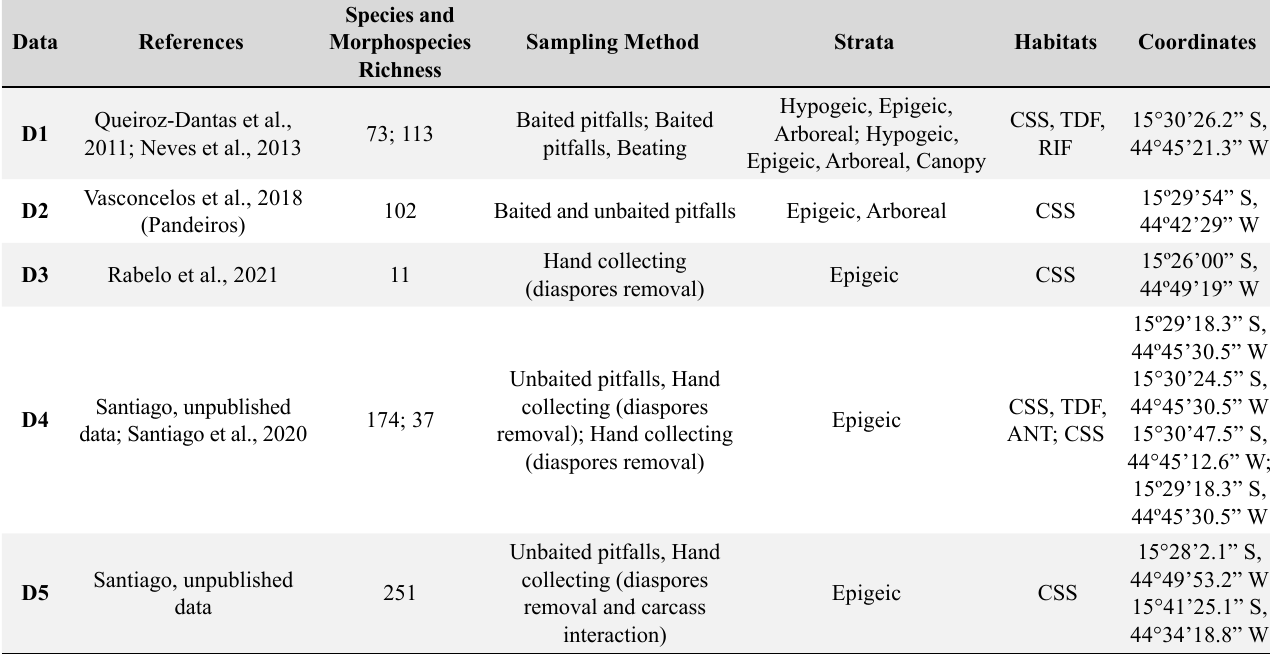
Table 1. References, species and morphospecies richness, sampling methods, strata, habitats and geographic coordinates related to datasets (Ds). A and B are parts of the same datasets published or considered separately: (D1) PCT-Hidro “Dinâmicas de organismos associados aos ambientes de matas ciliares, cerrado e floresta estacional decidual, no médio São Francisco, Norte de Minas Gerais”. (CNPq grant ED. 35/2006, no. 555978/2006-0); (D2) “Rede de Pesquisa Biota do Cerrado – Isoptera e Hymenoptera” (CNPq grant 457407/2012-3) and (FAPDF, Projeto PRONEX 563/2009); (D3, D4, D5) “Desenvolvimento de ferramenta para priorização de descomissionamento de Pequenas Centrais Hidrelétricas (PHC) no estado de Minas Gerais e estudo de caso para a PCH Pandeiros” (FAPEMIG APQ-03593-12). CSS = Cerrado sensu stricto ,TDF = Tropical Dry Forest, RIF = Riparian Forest, ANT = Anthropogenic